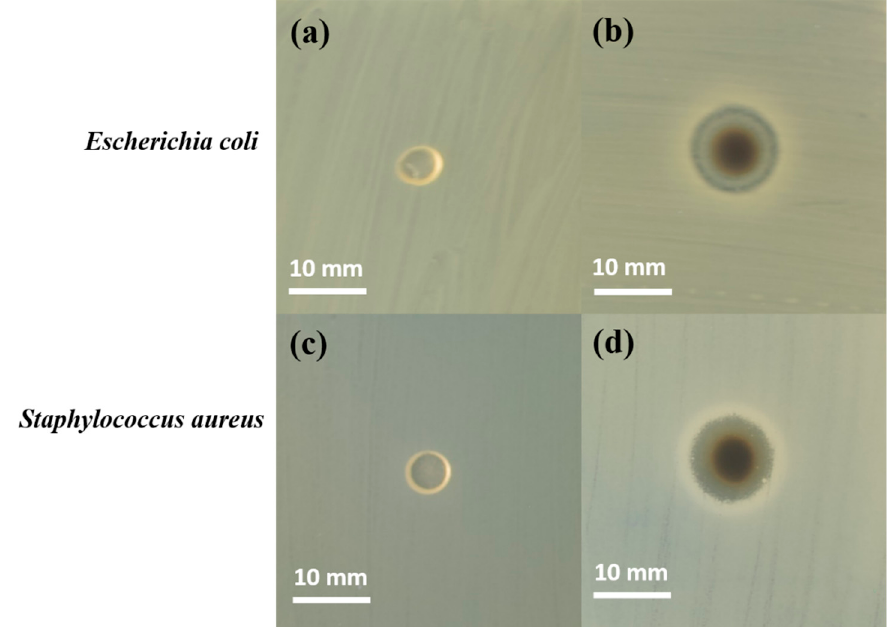
Figure 8. Formation of inhibition zone around KS ( a , c ) and Ag@KS ( b , d ) sponge discs against E. coli and S. aureus after 24 h incubation.